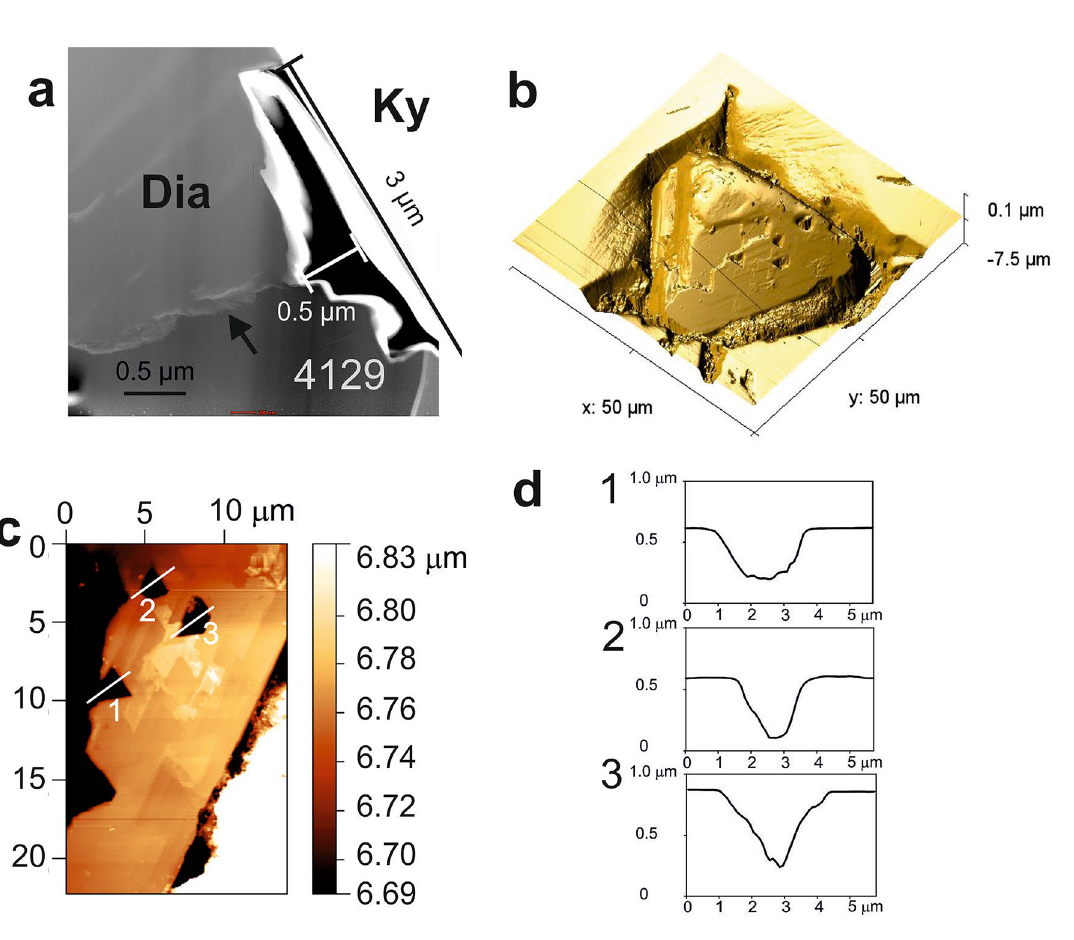
Figure 5. Dissolution phenomena on the surface of octahedral diamond. ( a ) High-angle annular dark-field (HAADF) image of a cross-section through funnel-shape trigonal etch pit on diamond-kyanite interface located at an outcropping dislocation array. ( b ) Negative trigonal etch pits on the octahedral face of diamond (AFM image). ( c , d ) Position and depth profiles of the trigons (AFM) which have similar dimensions and shape as the etch pit in ( a